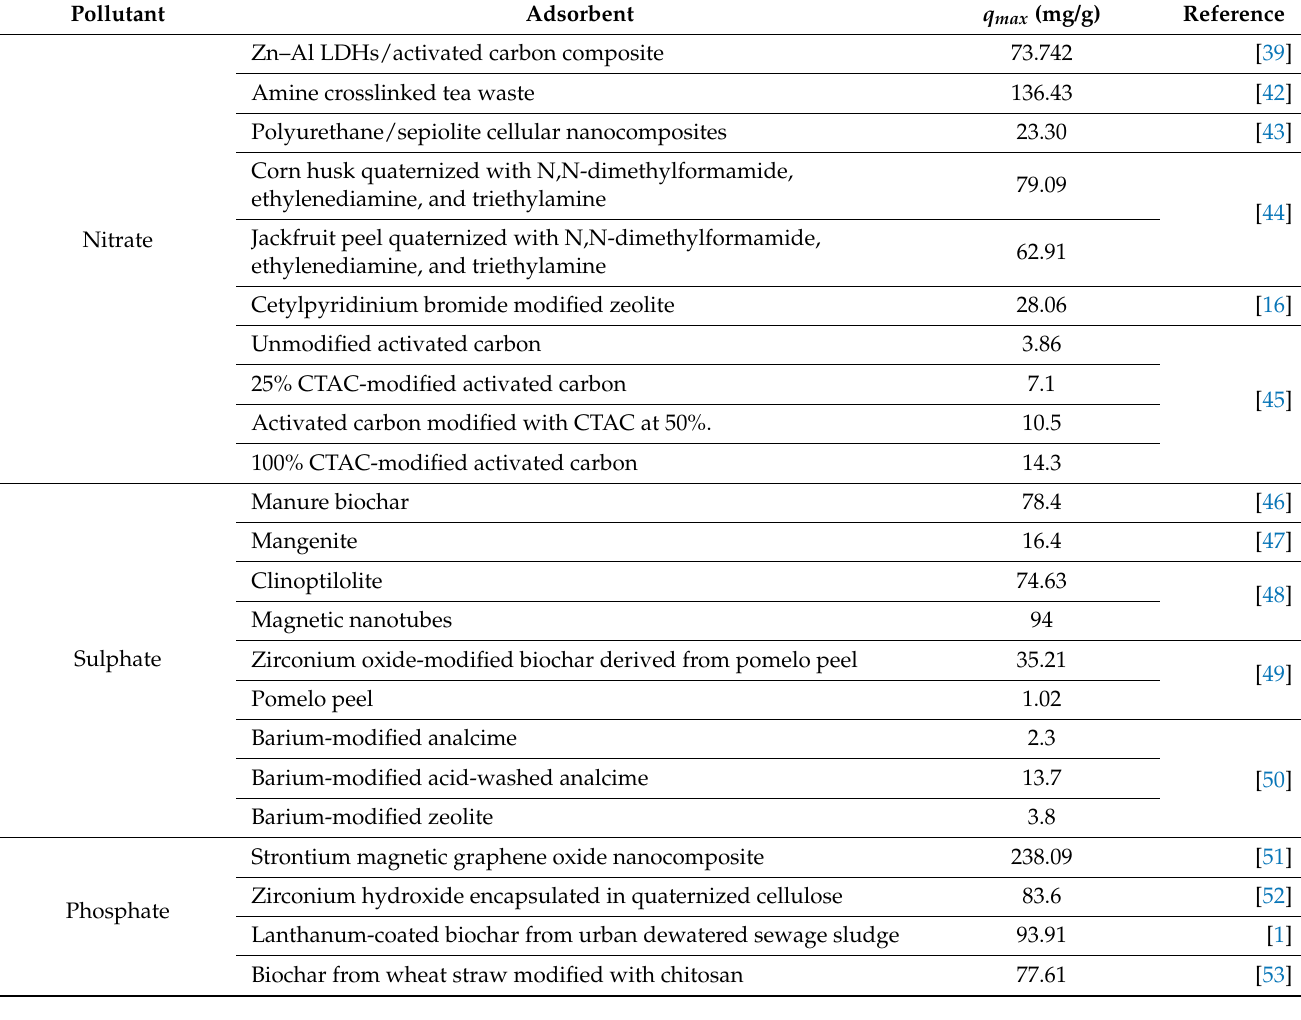
Table 3. Modelling adjustment parameters of the Cr (VI) adsorption isotherm.